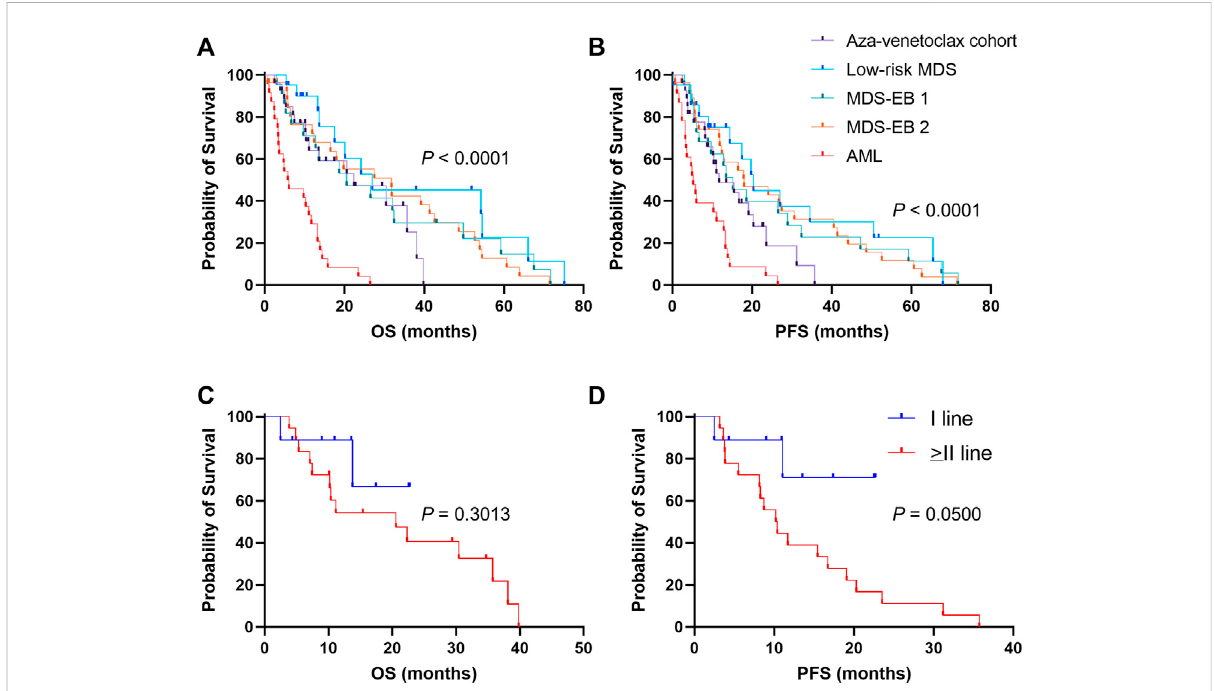
FIGURE 2 Clinical outcomes of patients treated with azacytidine plus venetoclax (A) overall survival (OS) and (B) progression-free survival (PFS) are reported for patientstreated with azacytidine plusvenetoclax (aza-venetoclaxcohort) orto azacytidine as single agent(historical cohort), divided by diagnosis [low-risk myelodysplastic syndrome (MDS), MDS with excess of blast (EB) of type 1 and 2, and acute myeloid leukemia (AML)] (C) OS e (D) PFSare also shown for patients of theaza-venetoclax cohort treatedwith thedrug combinationas upfronttherapy, or as asecond ormore line treatment. A p < 0.05 was considered statistically signi fi